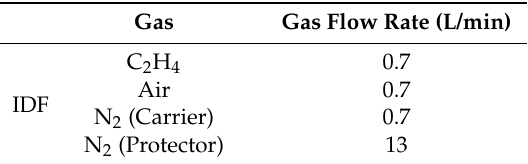
Figure 1. Schematic diagram of IDF experimental system. Table 1. Experimental conditions in inverse diffusion flame.